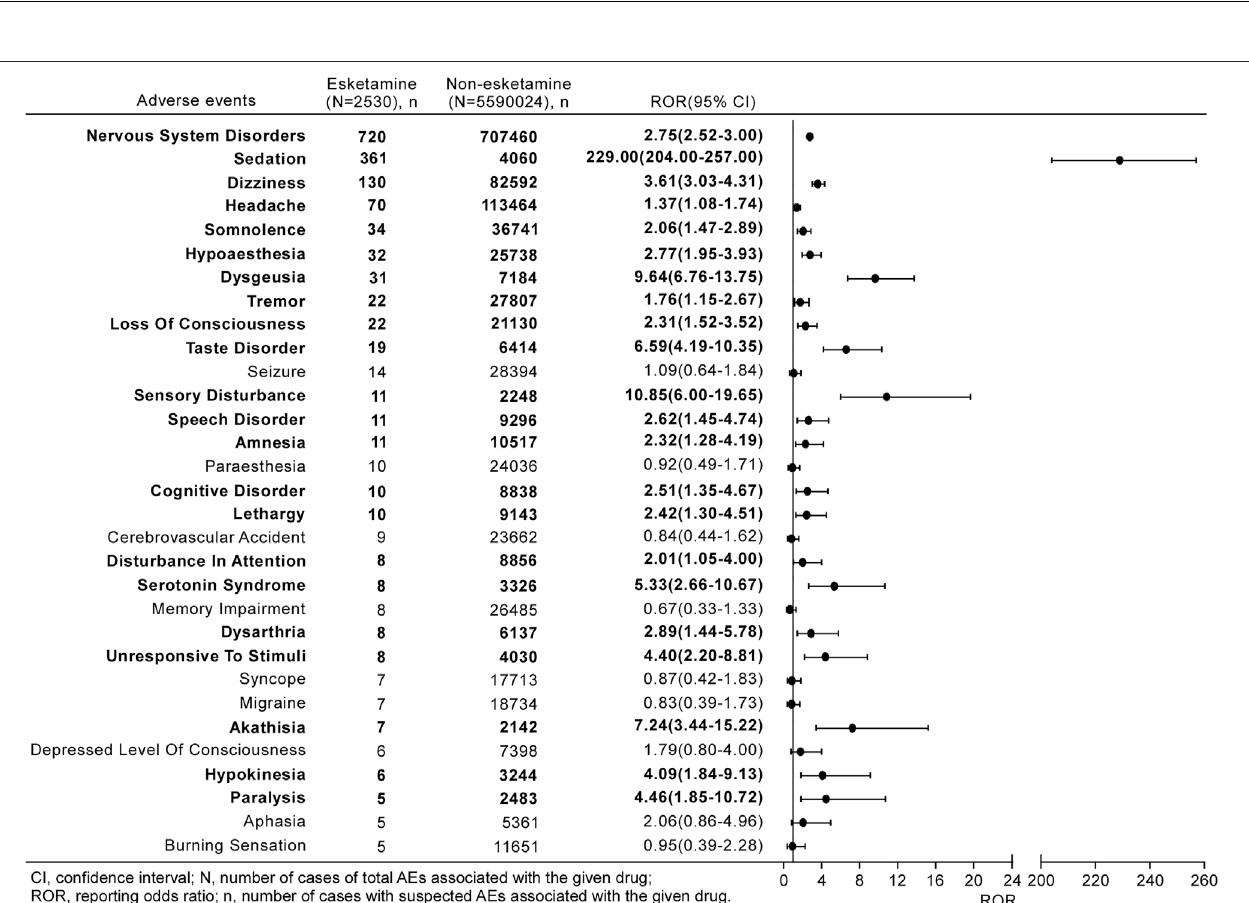
Frontiers in Pharmacology |